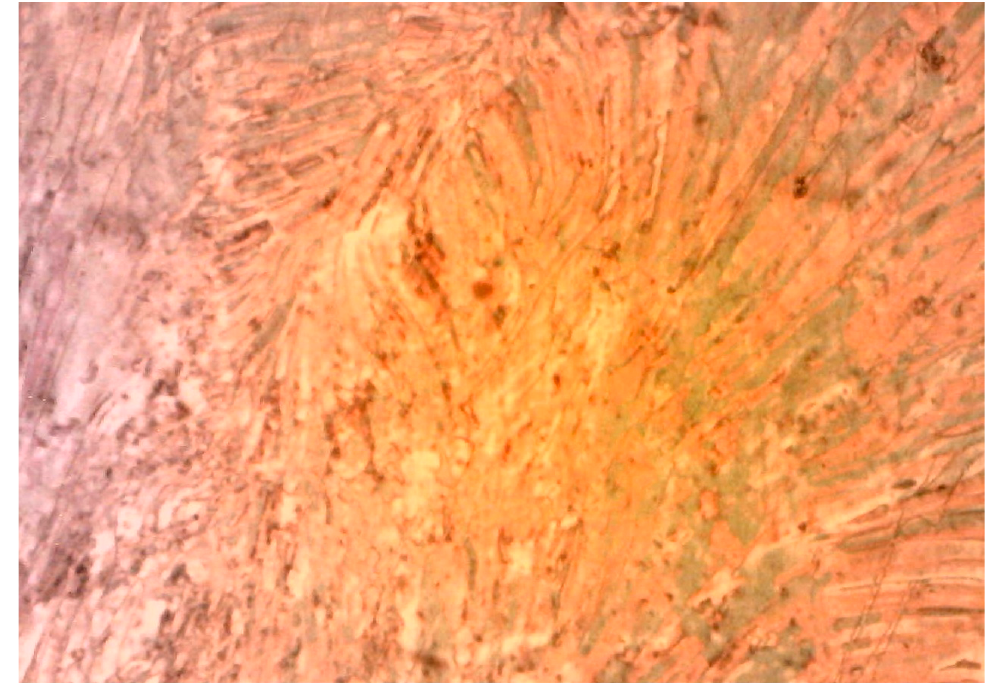
Figure 3. 12 − 8NCu/A6O − 8NCu binary mixture with composition of 25% in 12 − 8NCu at 98.8 °C ne- Figure 3. 12-8NCu/A6O-8NCu binary mixture with composition of 25% in 12-8NCu at 98.8 ◦ C matic schlieren texture. Crossed polarizers. nematic schlieren texture. Crossed